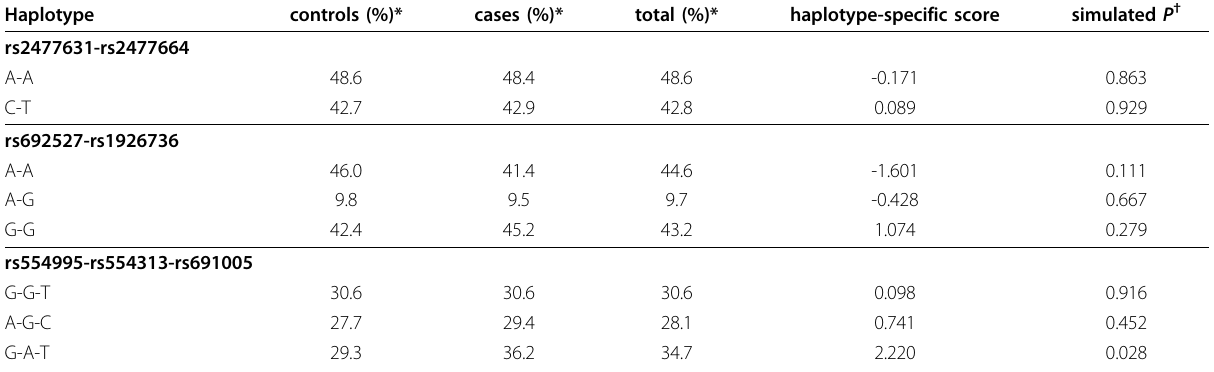
Table 5 Estimated haplotype frequencies and association with sarcoidosis